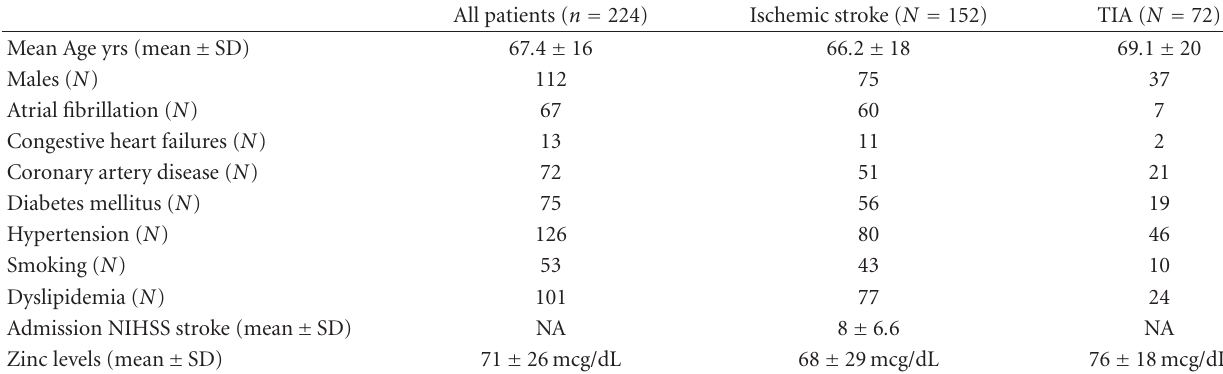
Table 1: Demographic characteristics ( N =